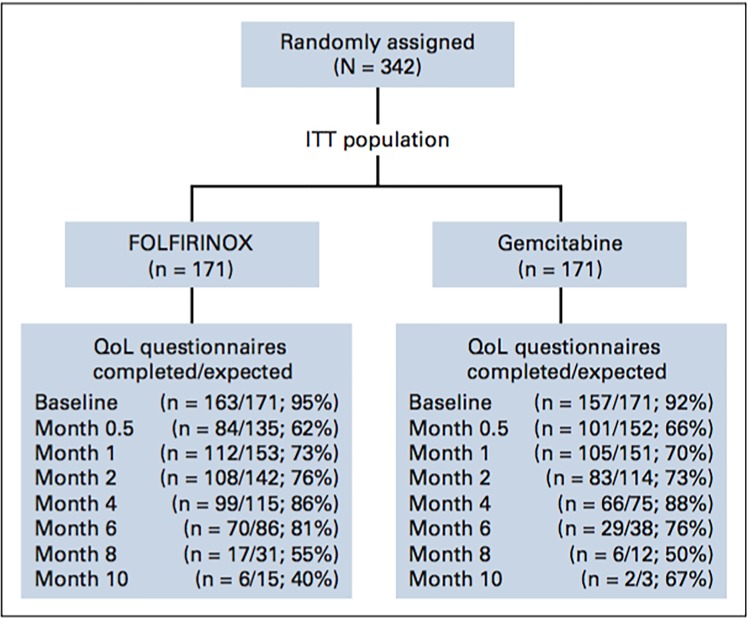
CONSORT diagram for European organisation for the research of cancer quality of life questionnaires C30 completed for the total number of eligible.